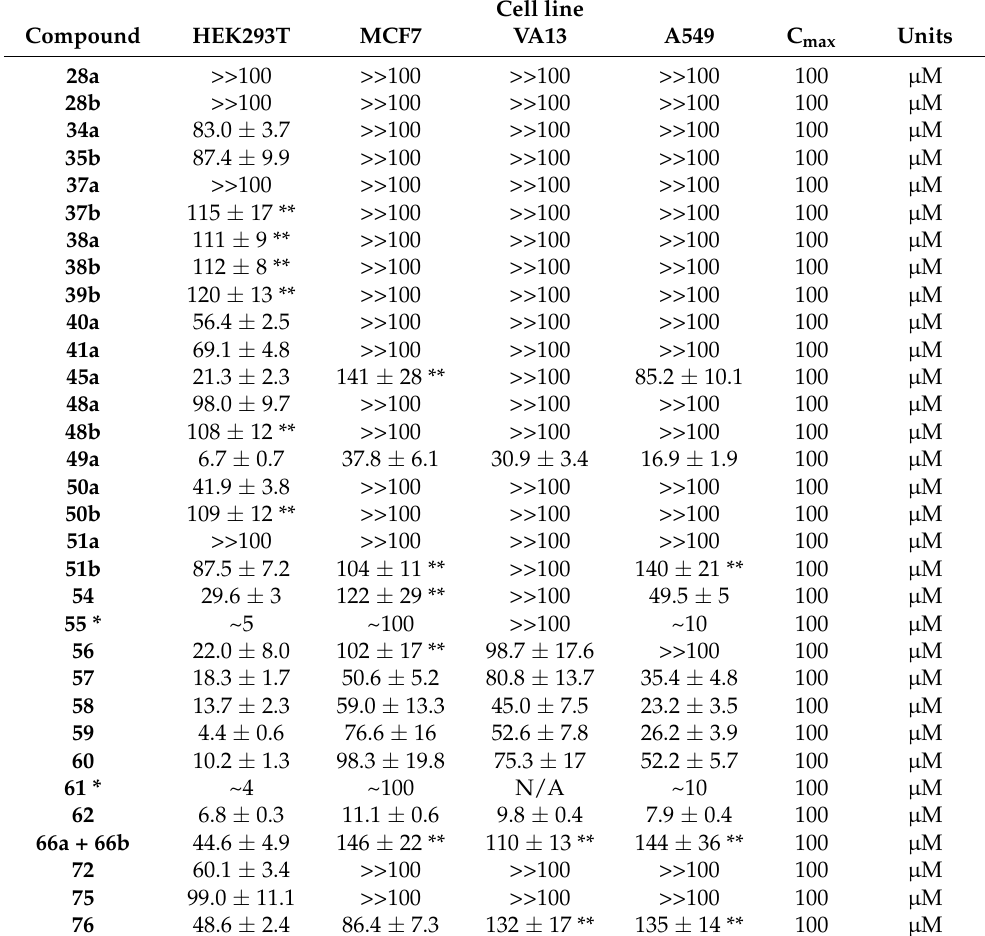
Table 5. Cytotoxicity effects of the compounds calculated as IC 50abs (IC 50abs —concentration of compounds, which caused 50% death of cells) for 65-h-treatment of the cell lines of different etiology using the standard MTT assay.